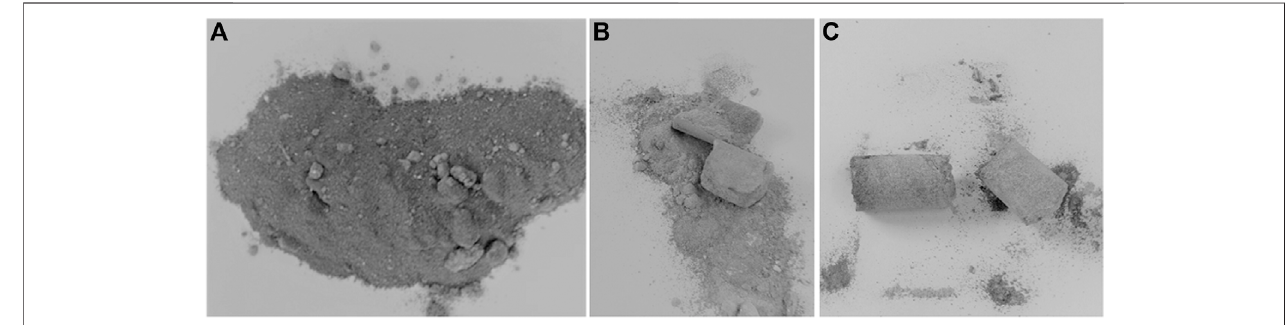
FIGURE 3 | Picture of the Fe/SiO 2 powder after Iron-silica-5 experiment (left) , Iron-silica-3 experiment (middle) and Iron-silica-8 experiment (right) .